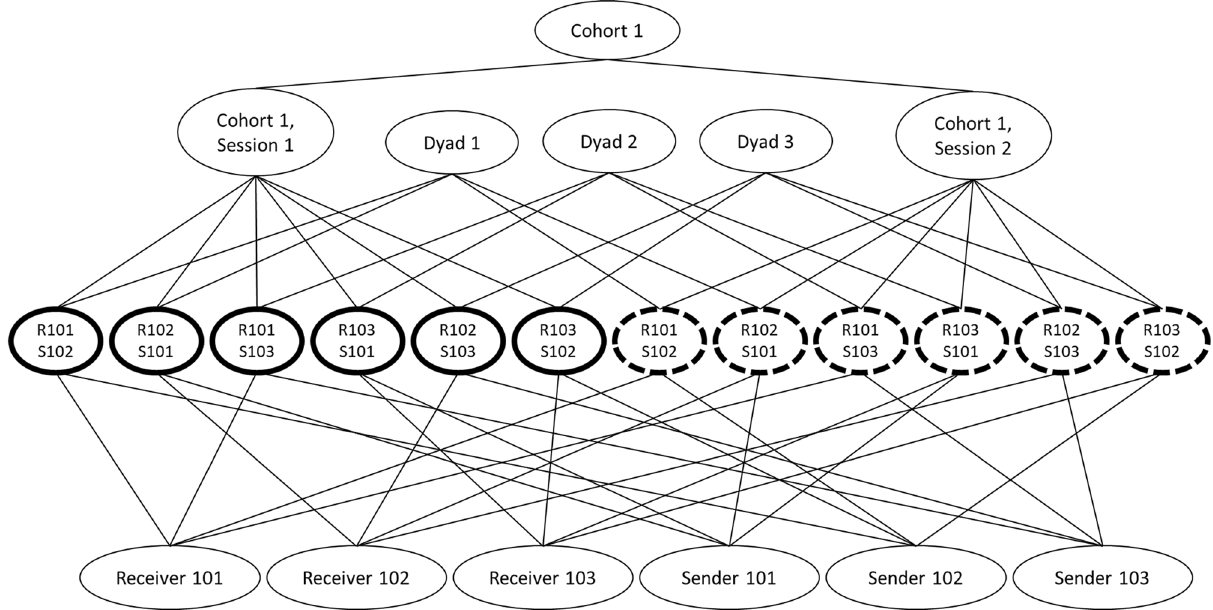
Figure 4. Structure of linkage estimates, displayed using an example of one cohort with two sessions and three people. Solid bold outlines indicate linkage estimates for Cohort 1 during Session 1; dashed bold outlines indicate linkage estimates for Cohort 1 during Session 2. The label of “R101, S102” indicates a linkage estimate for receiver 101 with sender 102. Dyads, receivers, and senders are not hierarchically nested within session because they are associated with linkage estimates across multiple sessions. Similarly, dyads, receivers, and senders are also not hierarchically nested within cohort because some facilitators participated in more than one cohort (see Supplement for more